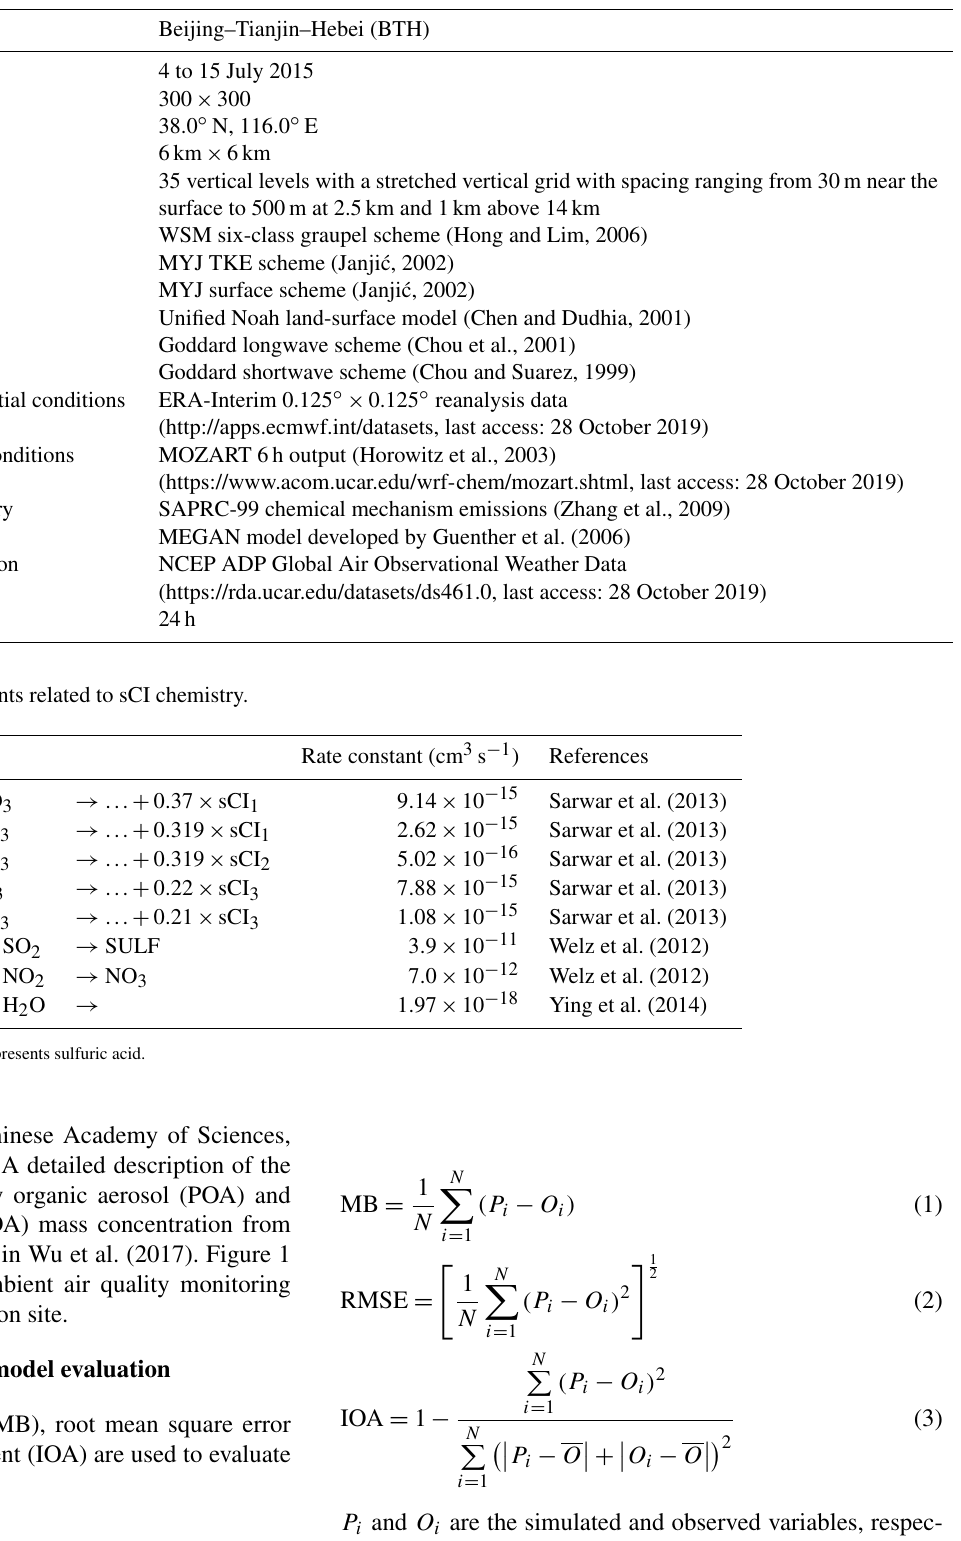
Table 1. WRF-Chem model configurations.